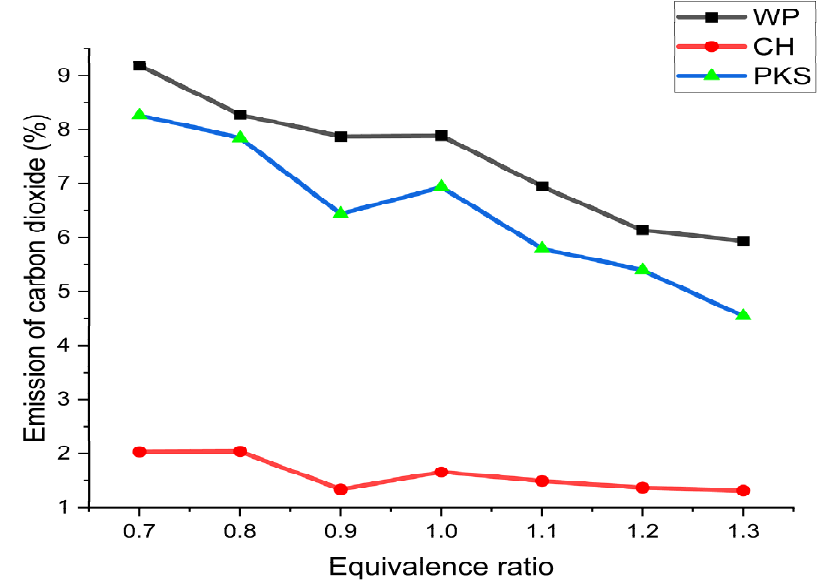
Figure 9. Emissions of carbon dioxide of 3 BPGs at 𝜙 from 0.7 to 1.3.